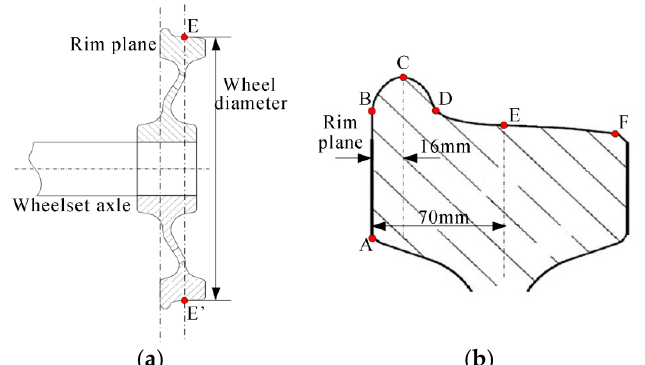
Figure 7. The profiles of the wheelset and tread. ( a ) The profile of half wheelset; ( b ) the profile of wheel tread; AB: the wheel rim plane; BD: the wheel flange; C: the flange vertex; DF: the wheel tread; E: the contact point.